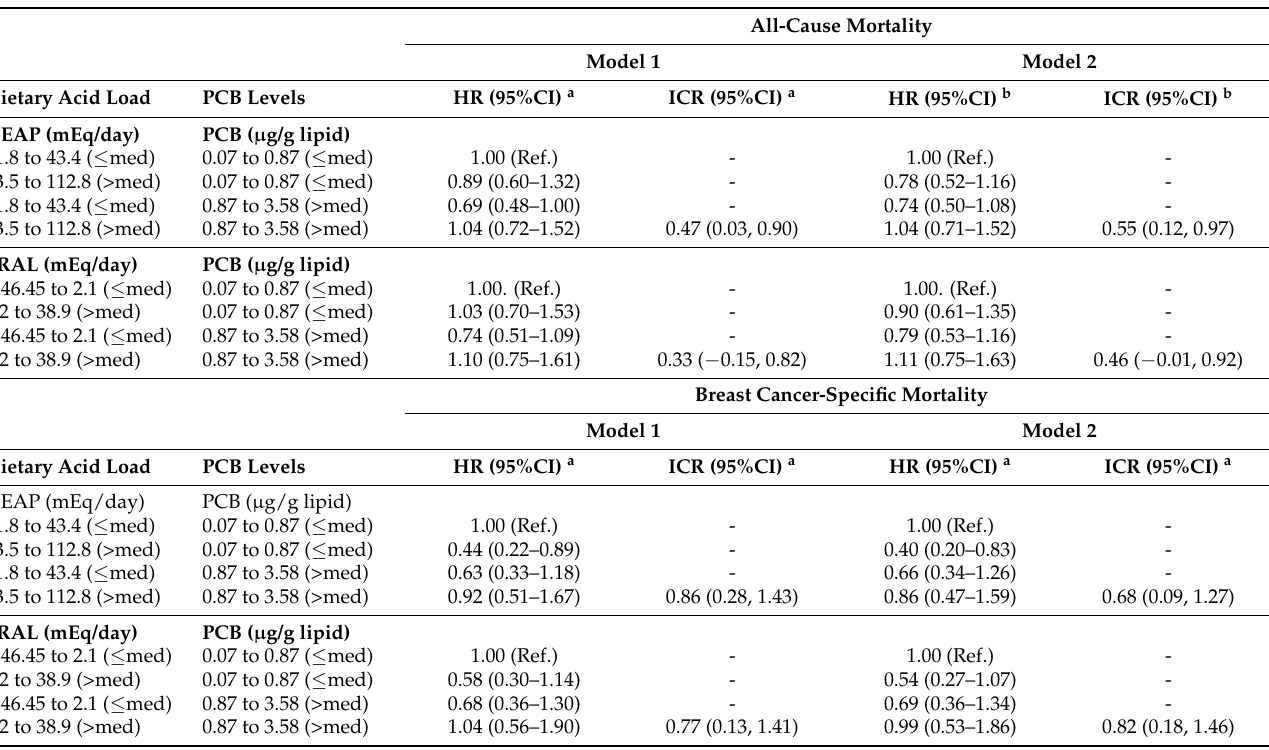
Table 3. Hazard ratios (HR) and 95% confidence intervals (CIs) for the associations between the joint effects of dietary acid load and total serum PCB levels and all-cause and breast cancer-specific mortality in the Long Island Breast Cancer Study Project ( n =